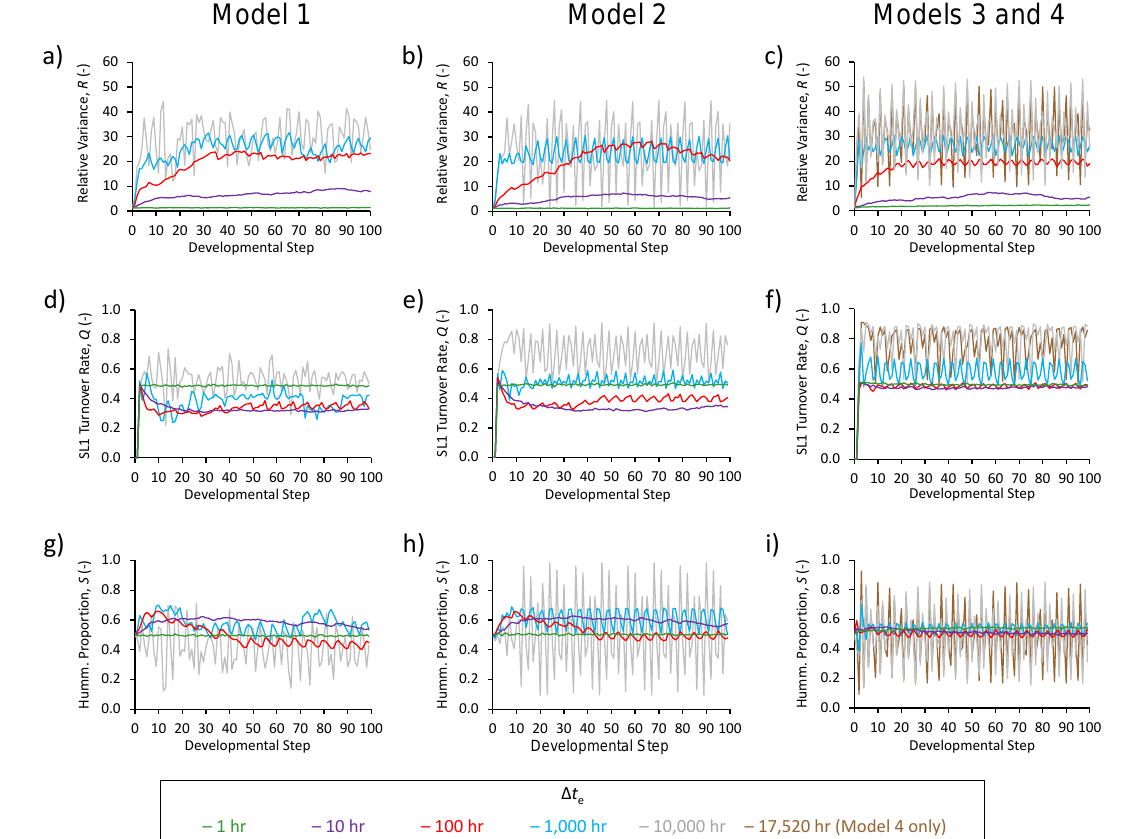
Figure 6. Influence of hydrological equilibration time, ∆ t e , over temporal development of relative variance of hummocks per model row, R (top row); SL1 turnover rate, Q (middle row); and proportion of model landscape occupied by hummocks, S (bottom row); in Models 1 (left column), 2 (middle column), 3 and 4 (right